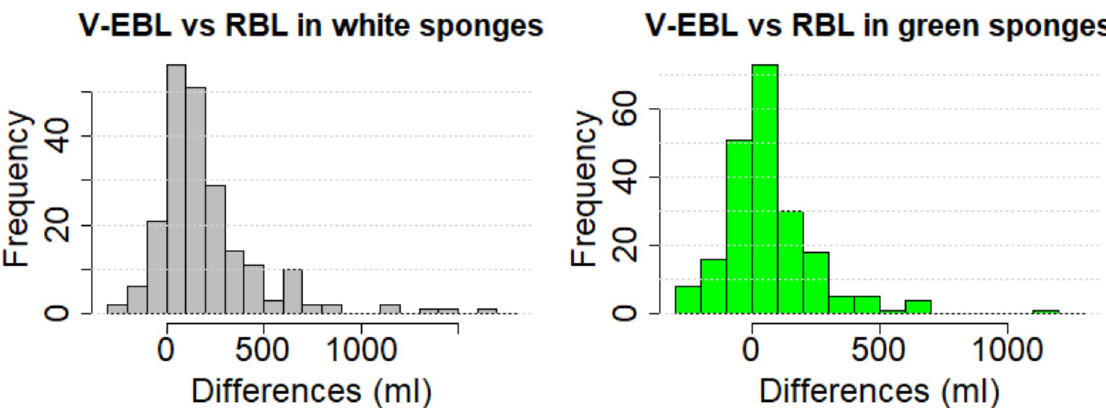
Fig 5. Histograms of differences. Histograms of differences between visually estimated (V-EBL) for white and green sponges and reference blood loss.